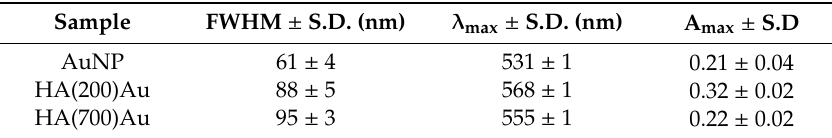
Table 1. Optical parameters (full width at half maximum, wavelength and absorbance at the maximum) from the UV-vis spectra of AuNP, bare and hyaluronic acid (HA)-conjugated samples. Averaged and standard deviation values from three repeated syntheses of each sample.